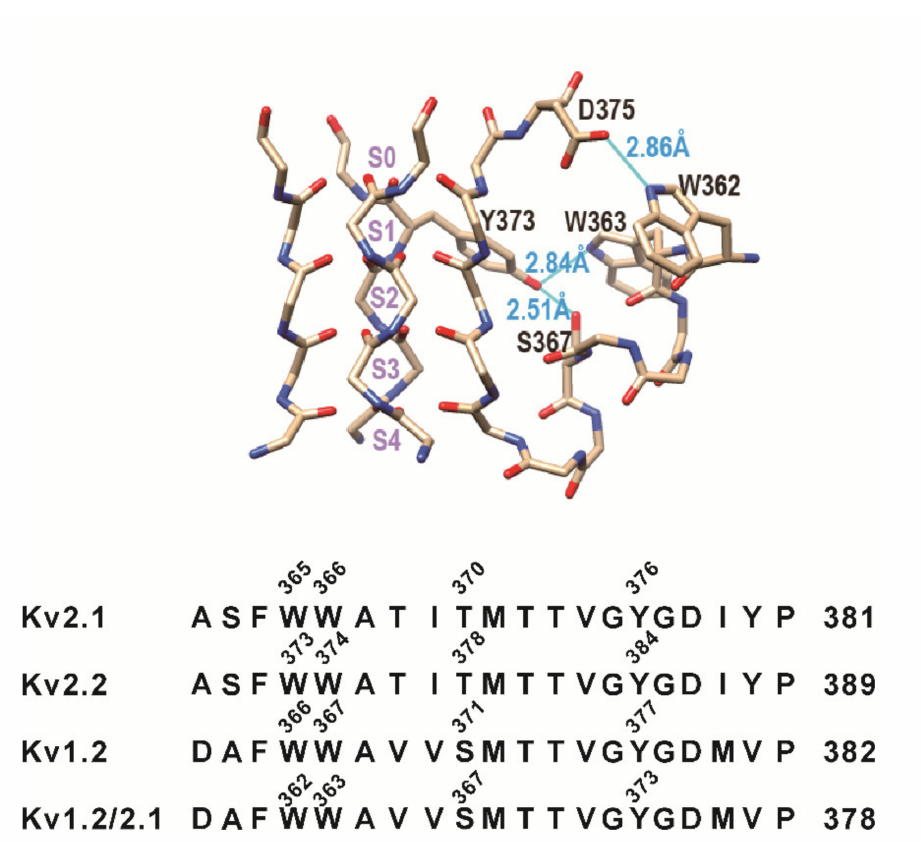
Figure 3. Selectivity filter structure of the Kv1.2/Kv2.1 chimeric channel (PDB: 2R9R) with the ion-binding sites S0–S4 labeled. The relevant pore helix residues and the three putative hydrogen bonds (blue lines) are labeled as